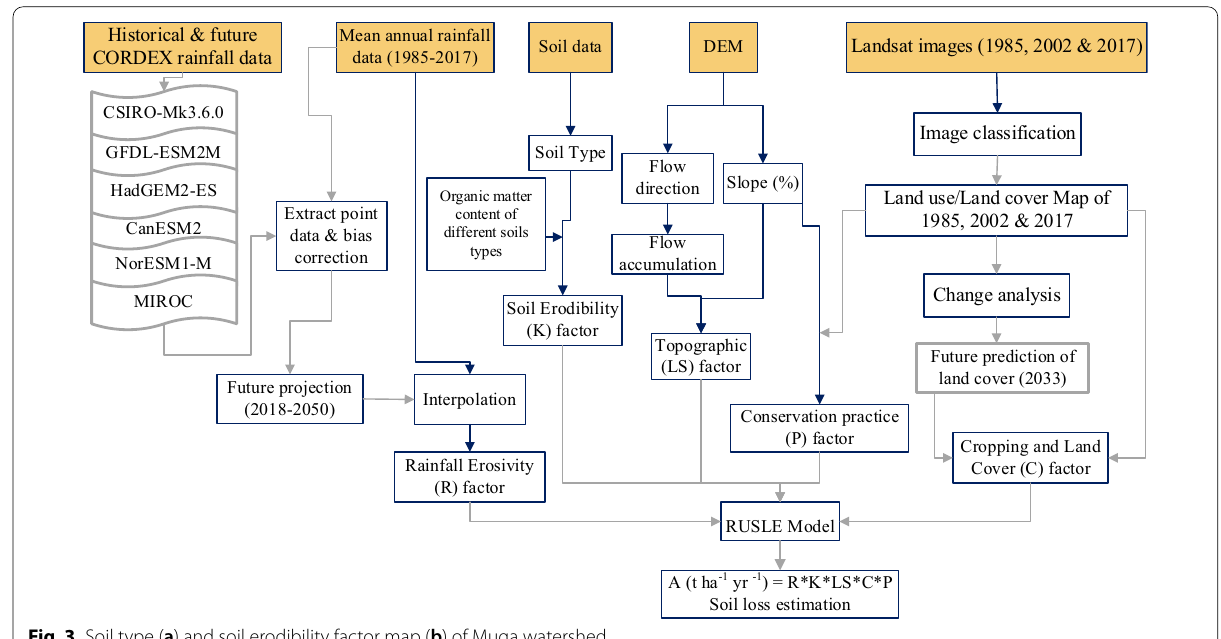
Fig. 3 Soil type ( a ) and soil erodibility factor map ( b ) of Muga watershed